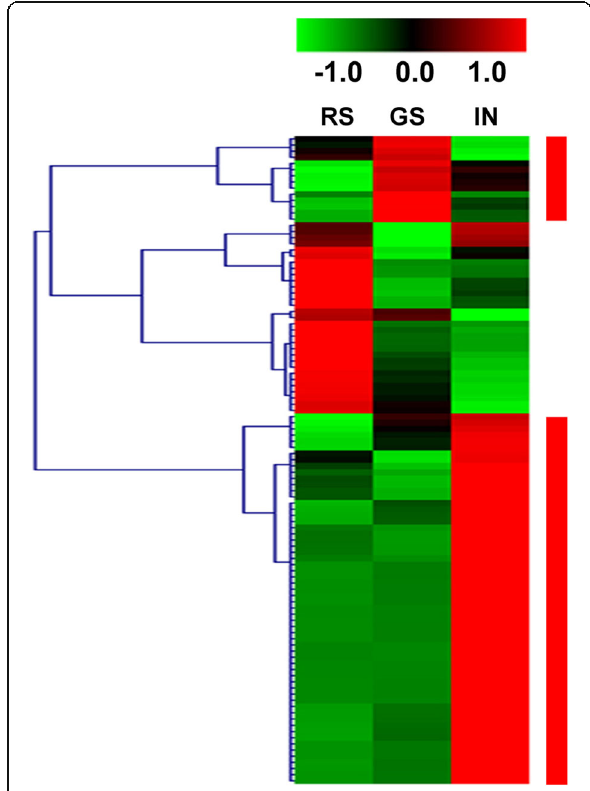
Fig. 4 Expression pattern of expanded and species-specific GPCR pathway related genes from Plasmodiophora brassicae. The expanded and species-specific GPCR pathway related genes show a specific expression pattern throughout growth and development of P. brassicae . For the expression values (Log2 (RPKM+ 1)), ranging from green ( − 1.0) to red (1.0), a Pearson correlation was used for distance calculations. The red rectangles indicating expression pattern of these GPCR pathway related genes show a high level during germinating resting spore stage (GS) and cortical infection stage (IN) compared to the resting spore stage